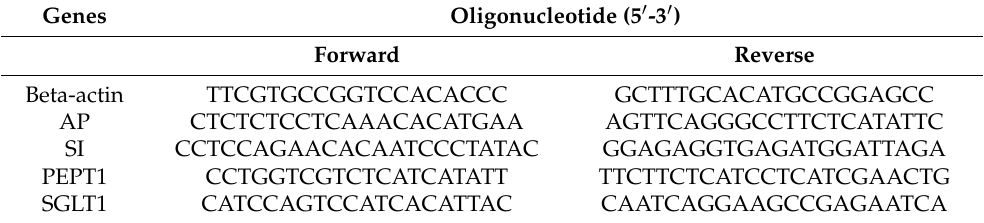
Table 2. Sequencing primers used in the RT-qPCR